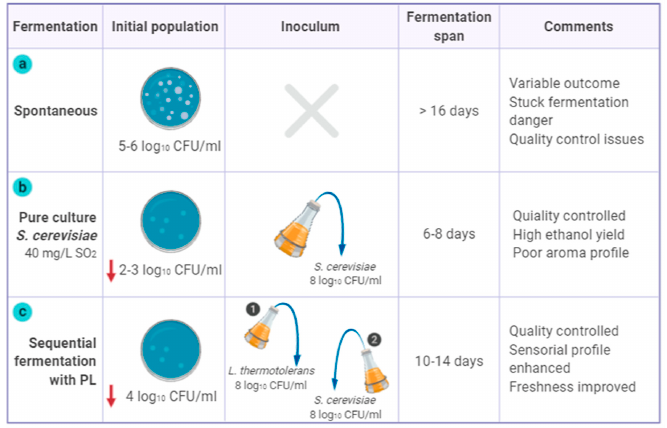
Figure4. Summarizedconditionscomparisonforthreedi ff erentfermentationscenarios: ( a )spontaneous fermentation, ( b ) conventional pure culture fermentation with sulphited must and ( c ) sequential fermentation using grapes previously sanitized with PL treatment. Adapted from